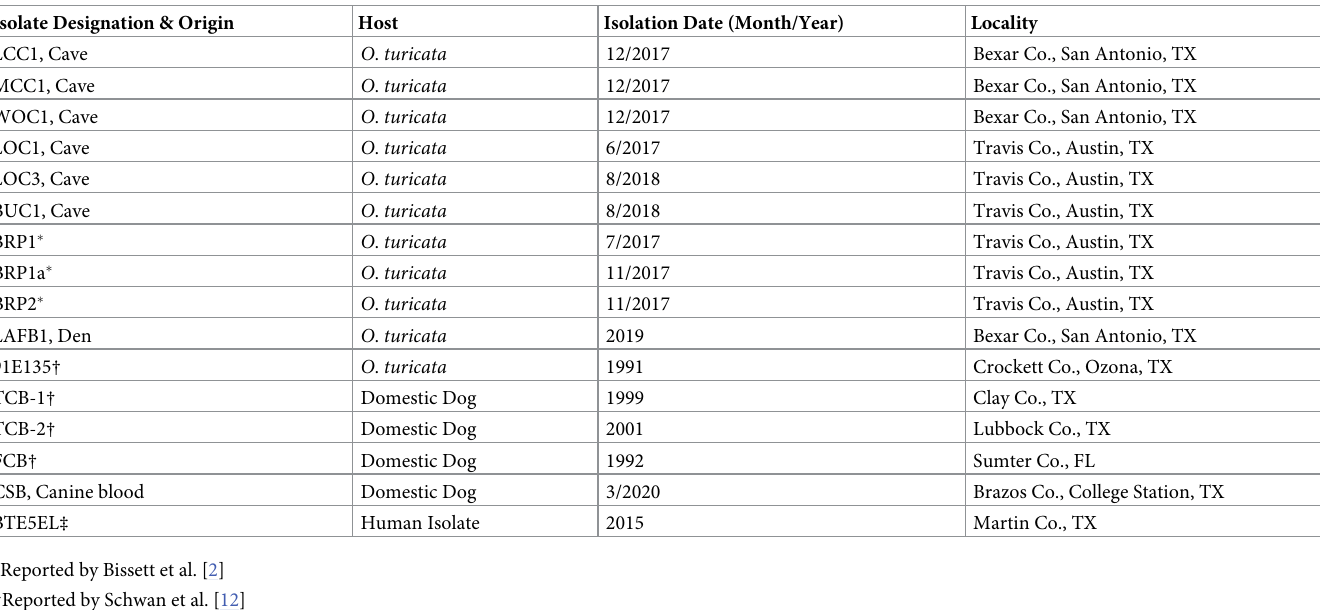
Table 1. Designations of Borrelia turicatae isolates used in this study and their biological sources, time of collection, and origin. Isolate Designation &